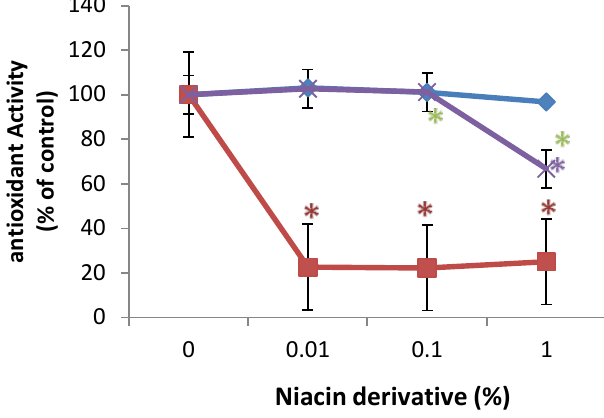
Figure 5. Direct inhibition of ABTS oxidation by 2,6-dihydroxynicotinamide (red line), 2,4,5,6-tetrahydroxynicotinamide (violet line), and 3-hydroxypicolinamide (blue